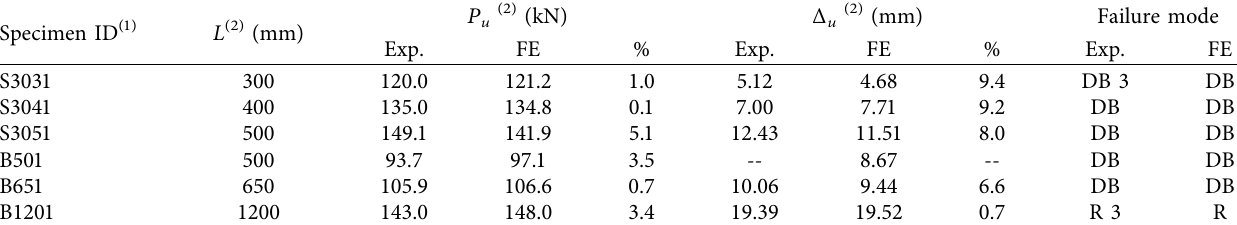
Table 4: Properties and key results of FRP-bonded steel beams, comparing experiments and FE models with the proposed τ –s model. Specimen ID (1)